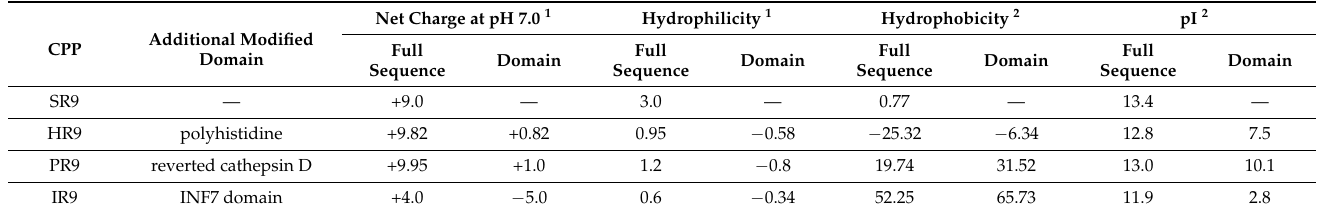
Table 2. The properties of four arginine-rich CPPs and their additional modified